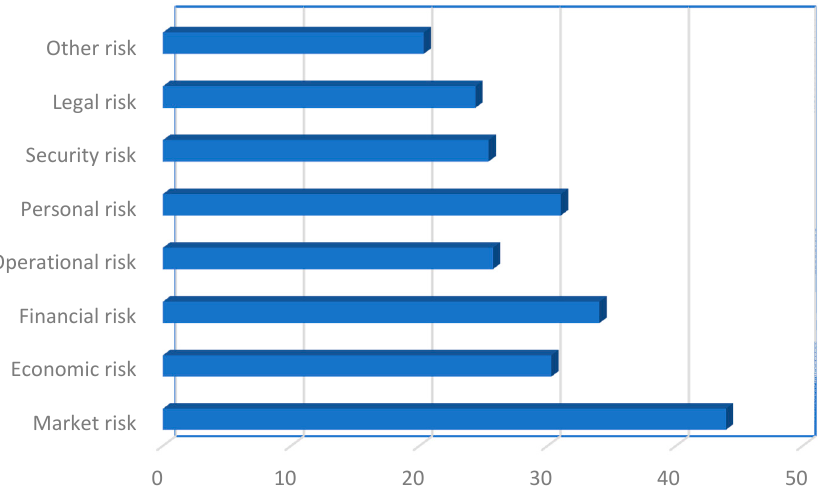
Figure 1. The assessment of the types of risk by small and medium enterprises.